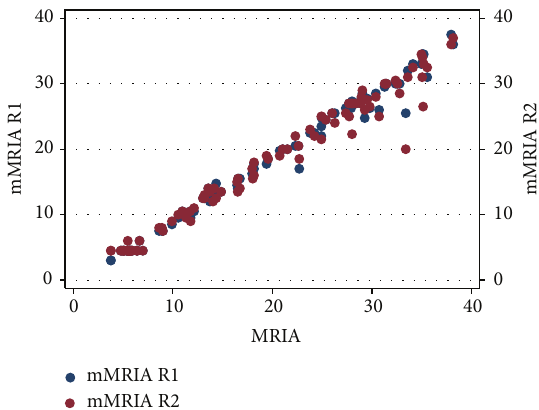
Figure 4: Box-plot of MRIA and mMRIA values of our series.